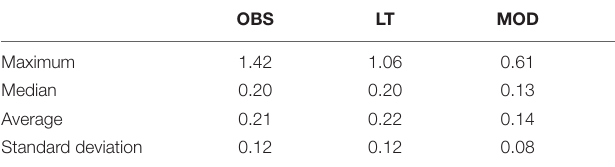
TABLE 1 | Descriptive statistics of velocities ( m · s − 1 ) for OBS, LT, and MOD.